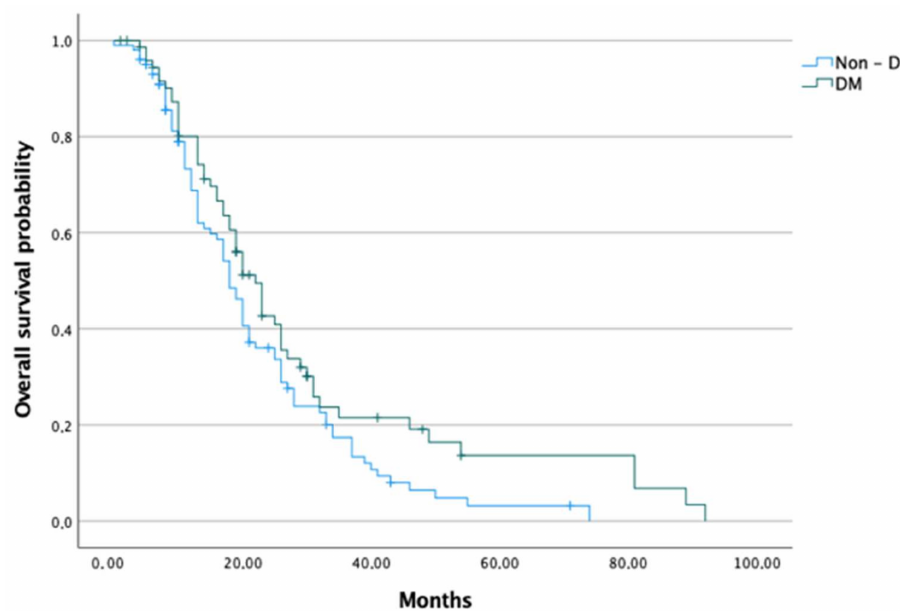
Figure 2. Overall survival of pancreatic cancer patients in DM and non-DM groups.